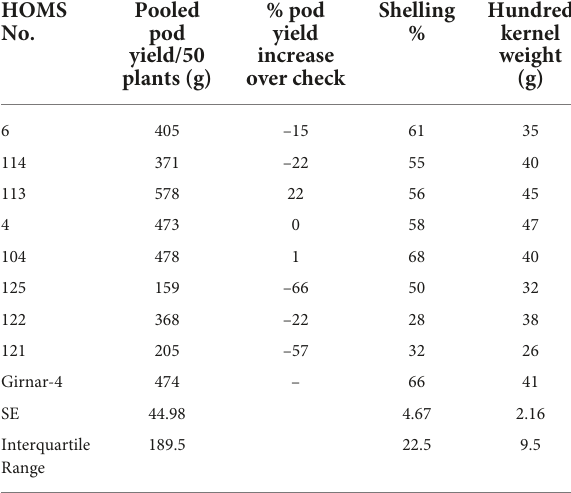
TABLE 2 Pod yield of Virginia bunch (VB) high oleic breeding lines, percent increase of pod yield over check, shelling% and hundred kernels weight in the post-rainy